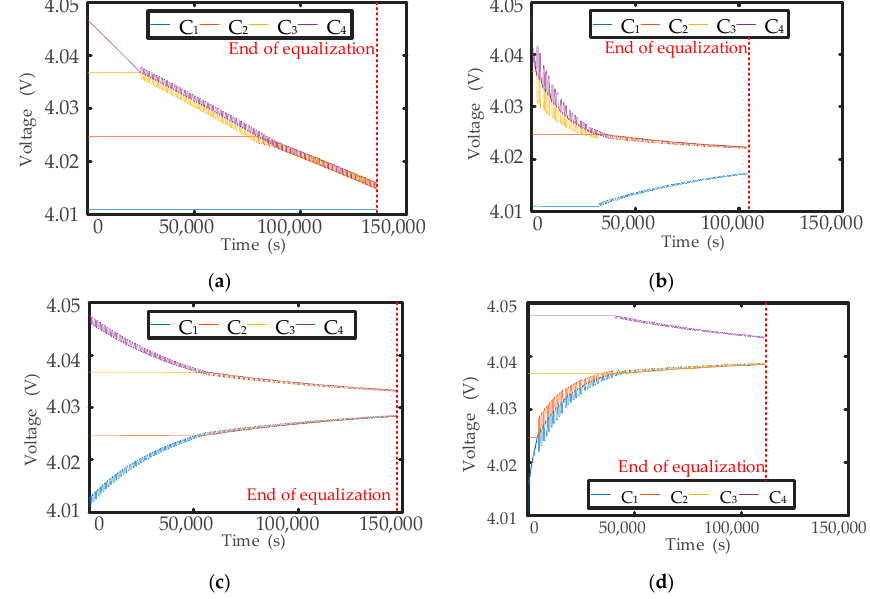
Figure 11. Simulation results of single equalization. ( a ) Passive equalization; ( b ) Active equalization (SOC of C 0 = 36%); ( c ) active equalization (SOC of C 0 = 52%); and ( d ) active equalization (SOC of C 0 = 68%).